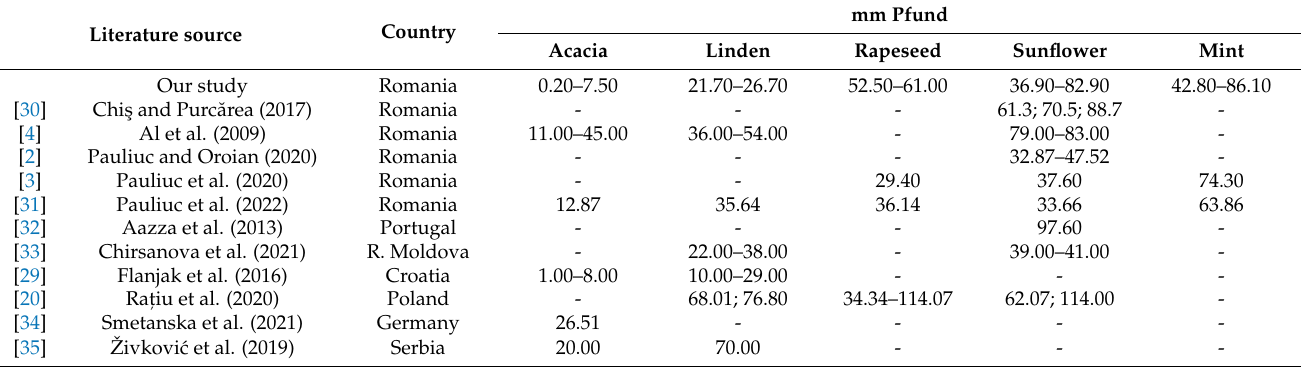
Table 3. Color intensity of different types of floral honey in our study and from literature sources.